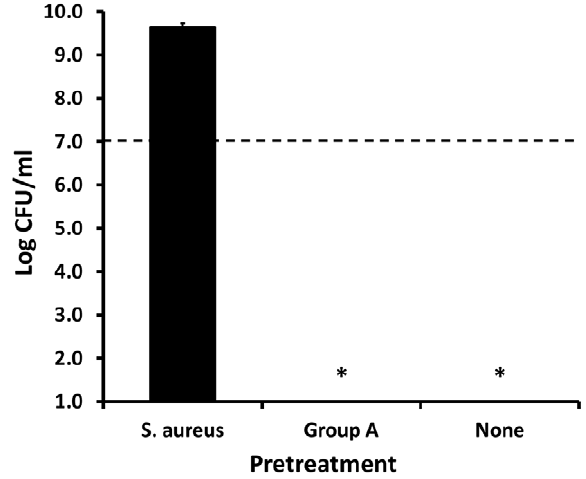
Figure 3. Ability of pretreatment of GML with Staphylococcus aureus MN8 spent culture fluids to reduce antimicrobial activity. Staphylococcus aureus MN8 or Streptococcus pyogenes T25 3 curedT12 sterile stationary phase culture fluids were incubated with GML (1000 m g) for 24 hours. Subsequently, treated GML was evaluated for antibacterial activity against Staphylococcus aureus MN8 in a 24 hour assay, in comparison to untreated GML. * indicates mean significantly reduced from starting inoculum mean at p , 0.001. Dashed line indicates starting inoculum size.